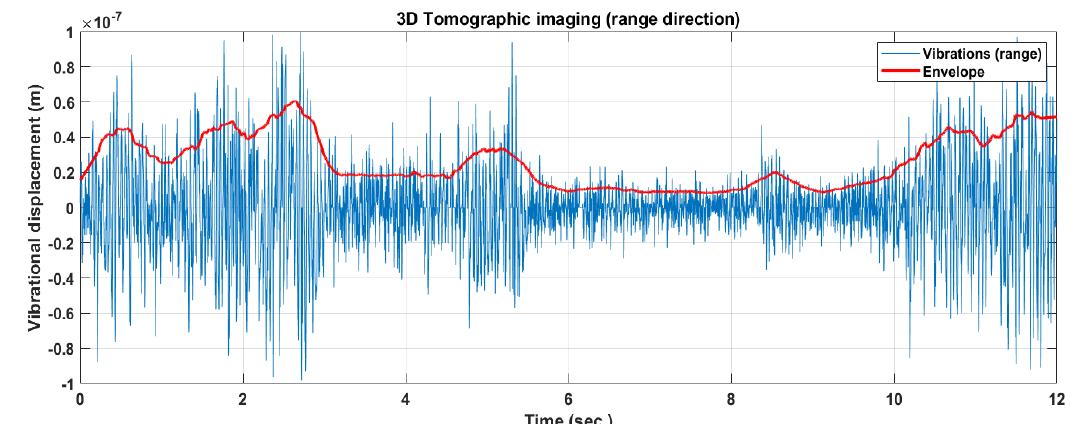
Figure 5. Time domain vibrations in the range direction